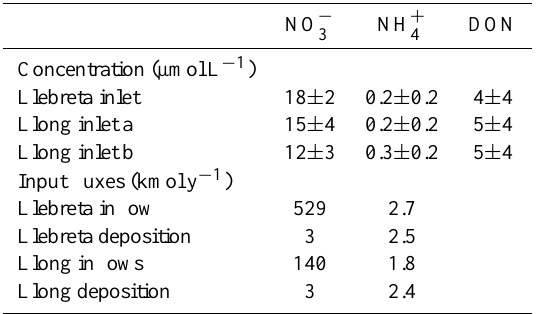
Table 2. Average dissolved nitrogen concentration in inlets (June 2004 to April 2006) and annual loading (2006) into two of the lakes